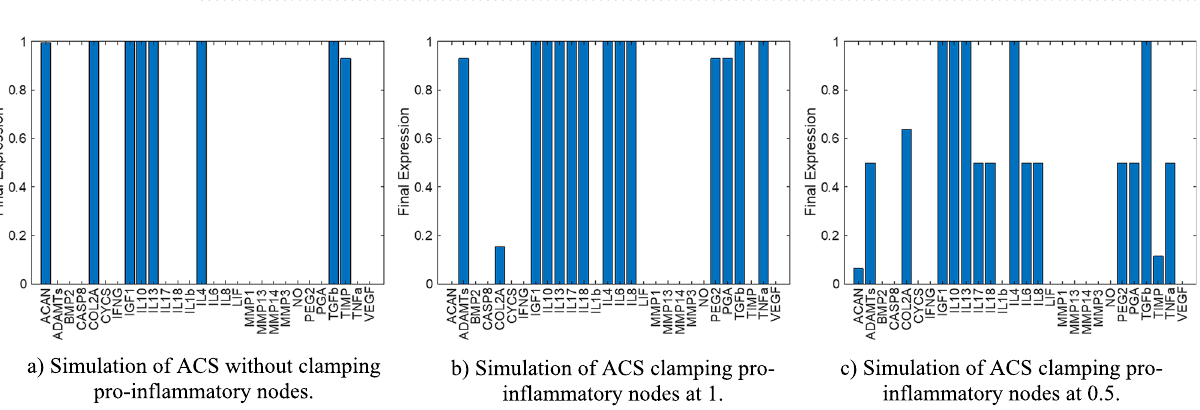
Figure 6. Normalized root squared error (NRSE) data point by data point before (at left) and after (at right) the optimization for the test set. Black squares are not considered when calculating the NRSE because the same protein used to perturb the model was then measured.